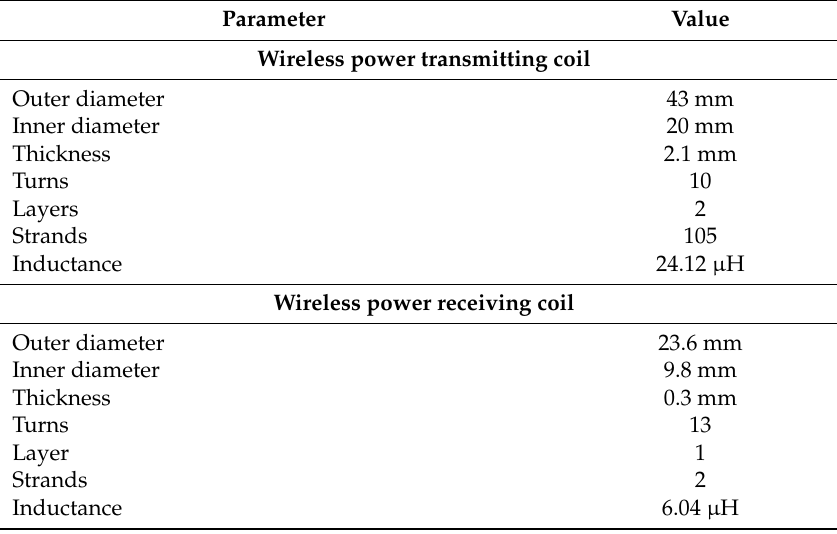
Table 2. Characteristics of the wireless power transmission